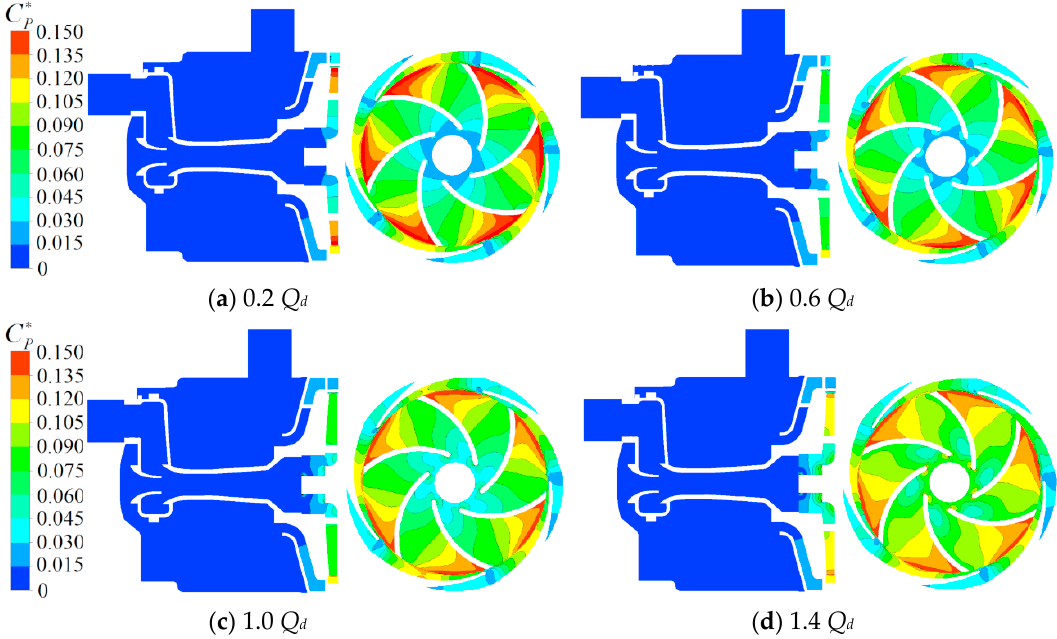
Figure 8. Fluctuation intensity distribution contours of pressure on two planes under four conditions.